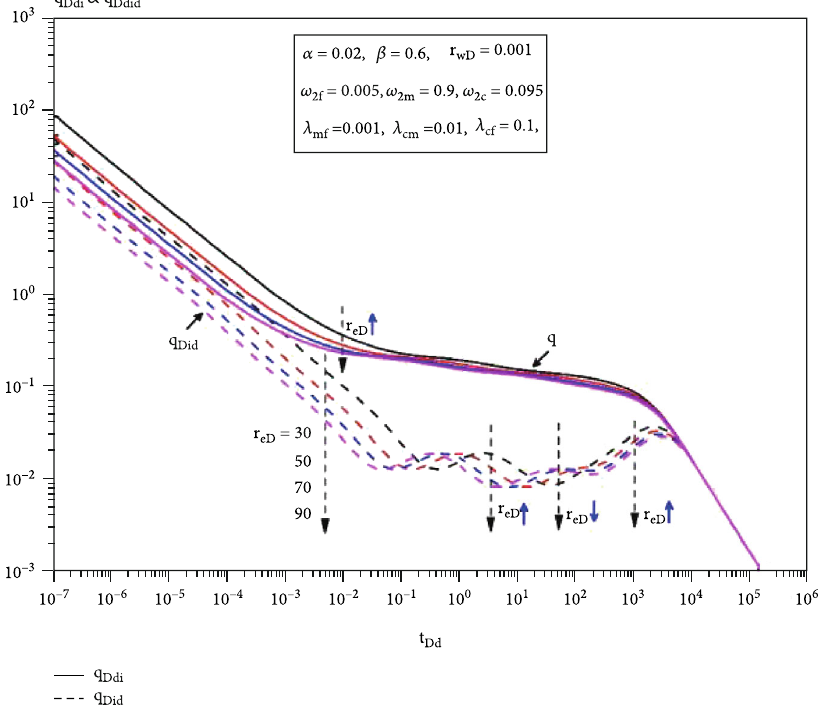
Figure 15: New rate decline curves of an AFVW in a pore-cavity-fracture carbonate reservoir under di ff erent reservoir